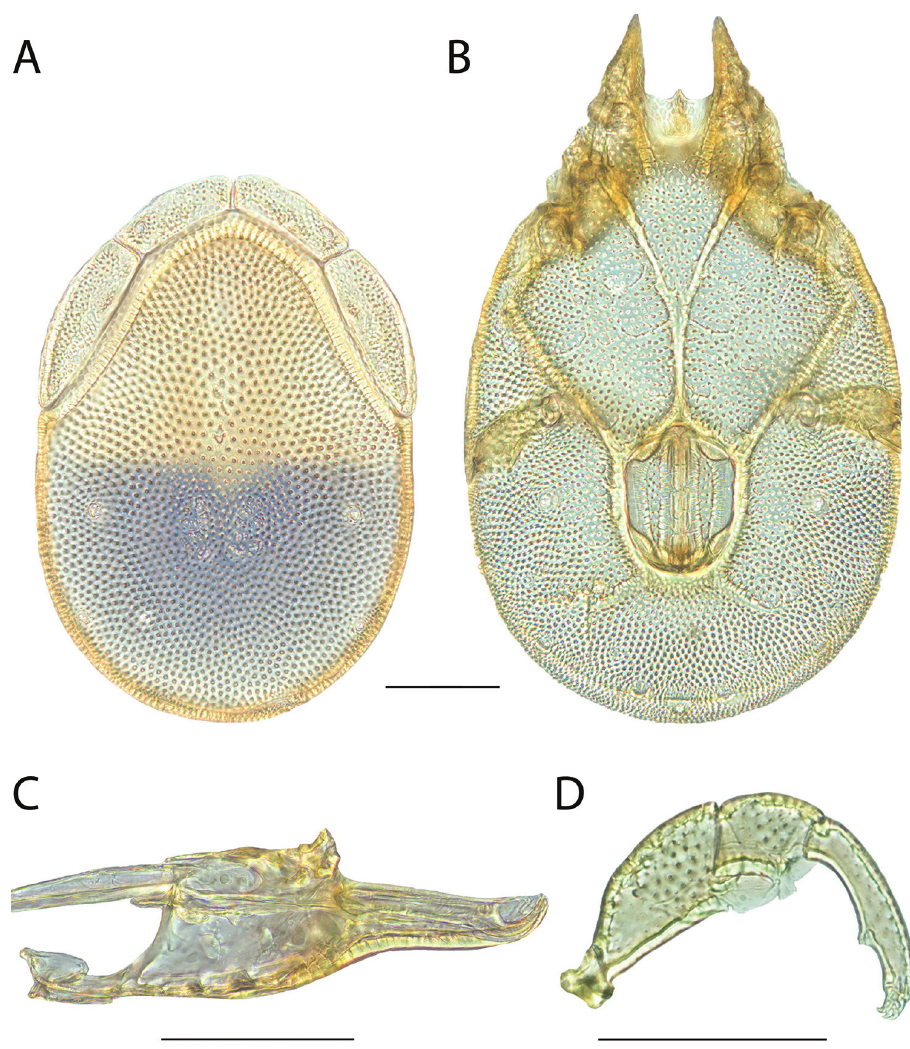
Figure 80. Torrenticola flangipalpa sp. n. male: A dorsal plates B venter (legs removed) C subcapitulum D pedipalp (setae not accurately depicted). Scale = 100